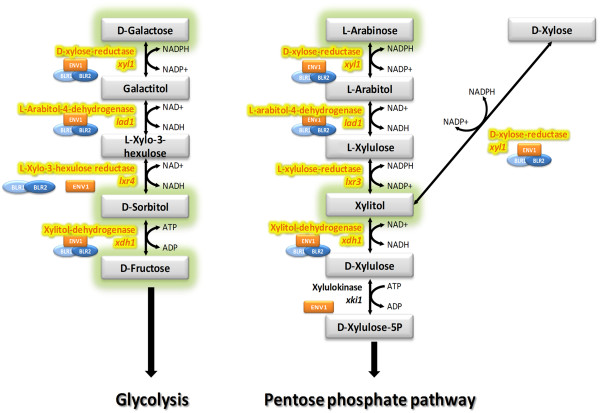
Schematic representation of pentose and D-galactose catabolism in light. Enzymes encoded by genes, which are positively regulated in light are highlighted in yellow. An influence of BLR1, BLR2 or ENV1 is indicated by their pictograms next to the enzyme. Metabolic intermediates of the pathway, on which growth is enhanced in light (BIOLOG assay) are represented with a green shadow. From the remaining intermediates, only D-xylose was also part of the assay, but no differences in growth were observed in wild-type or mutant strains. Galactitol, L-Xylo-3-hexulose, L-arabitol, D-Xylulose were not tested.